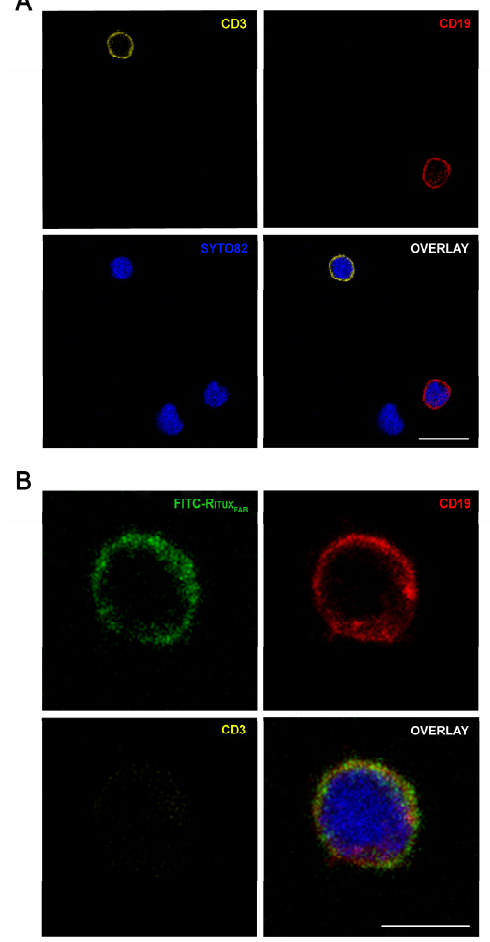
Figure 7. Confocal microscopy analysis of FITC-Ritux Fab in HD PBMC. Images show the expression of CD3+ (pseudocolored in orange, upper left panel) and CD19+ (red, upper right panel) cells ( A ) and the presence of FITC-Ritux Fab (green, upper left panel) in CD19+ (red, upper right panel) cells and the simultaneous absence in CD3+ (orange, lower left panel) ( B ) among lymphocytes within the human PBMC pool from HD. Cell nuclei are counterstained with SYTO™82 dye (pseudocolored in blue). Scale bars = 10 µm ( A ) and 5 µm ( B ).